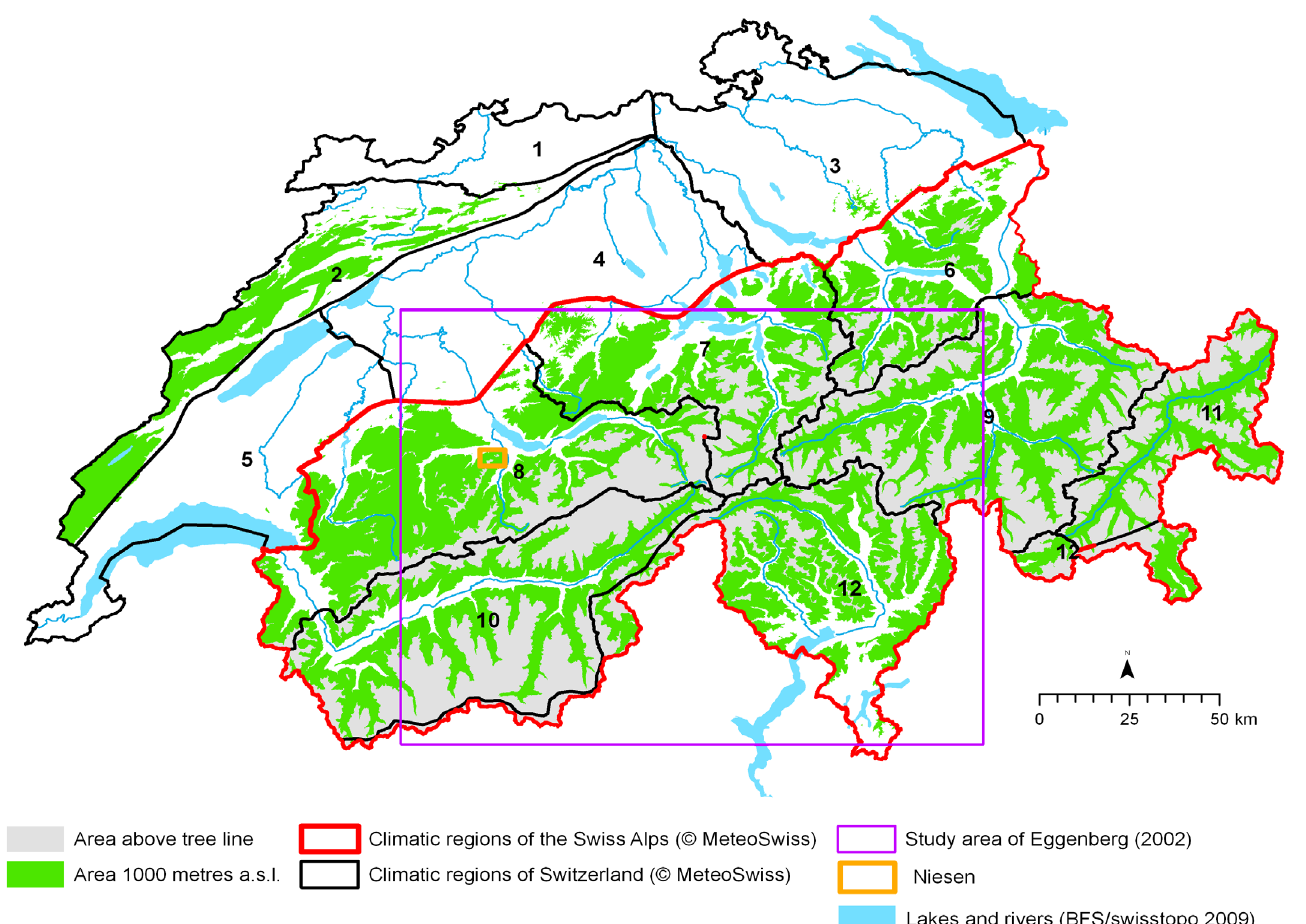
Figure 2. The map shows the area exceeding an altitude of 1000 m.a.s.l. (green) and the area above the tree line (grey). The purple box indicates the perimeter of reference data from the study of Eggenberg (2002) (Figs. 10 and 11). The orange box indicates the boundary of Figs. 3, 5, and 6, which show intermediate results of the analysis for the example of Niesen ridge. The red and the black lines delimit the climatic regions by Schüepp & Gensler (1980) which served as spatial reference units for the explorative analyses. They include: 1 Eastern Jura, 2 Western Jura, 3 North-eastern Swiss Plateau, 4 Central Swiss Plateau, 5 Western Swiss Plateau, 6 Eastern part of the Northern Alps, 7 Central part of the Northern Alps, 8 Western part of the Northern Alps, 9 Northern and central Grisons, 10 Valais, 11 Engadin, 12 Southern Alps. The red line encloses the climatic regions of the Swiss Alps which is the perimeter of Figs. 7, 8, and